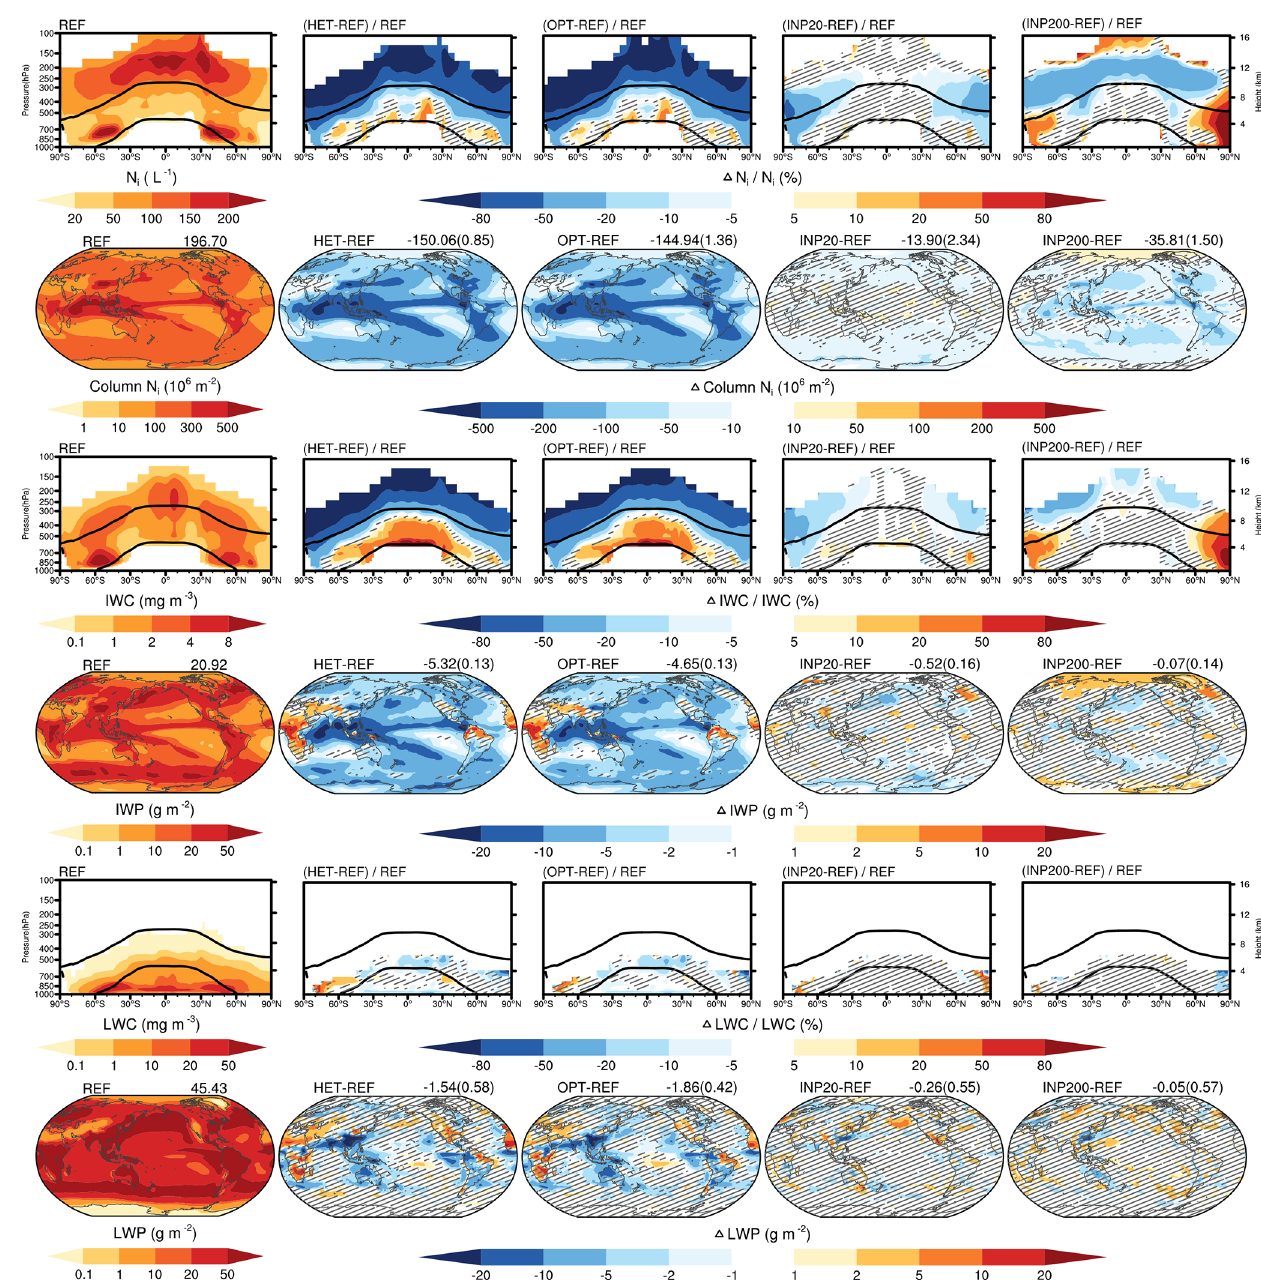
Figure 3. Annual zonal mean of in-cloud IC number concentration ( N i , first row), ice water content (IWC, third row), and liquid water content (LWC, fifth row) from the REF experiment (first column) and the relative changes from the HET, OPT, INP20, and INP200 experiments with respect to the REF experiment (second to fifth columns). The corresponding spatial distributions of vertically integrated N i (column N i , second row), ice water path (IWP, fourth row), and liquid water path (LWP, sixth row) from the REF experiment and the differences (“ (cid:49) ”) from the HET, OPT, INP20, and INP200 experiments with respect to the REF experiment. Global mean values are shown in the upper right corner, and the standard deviations calculated from the difference of each year for 10 years are shown in brackets. The shadow denotes that the differences between two experiments are not significant at the 95% level based on Student’s t